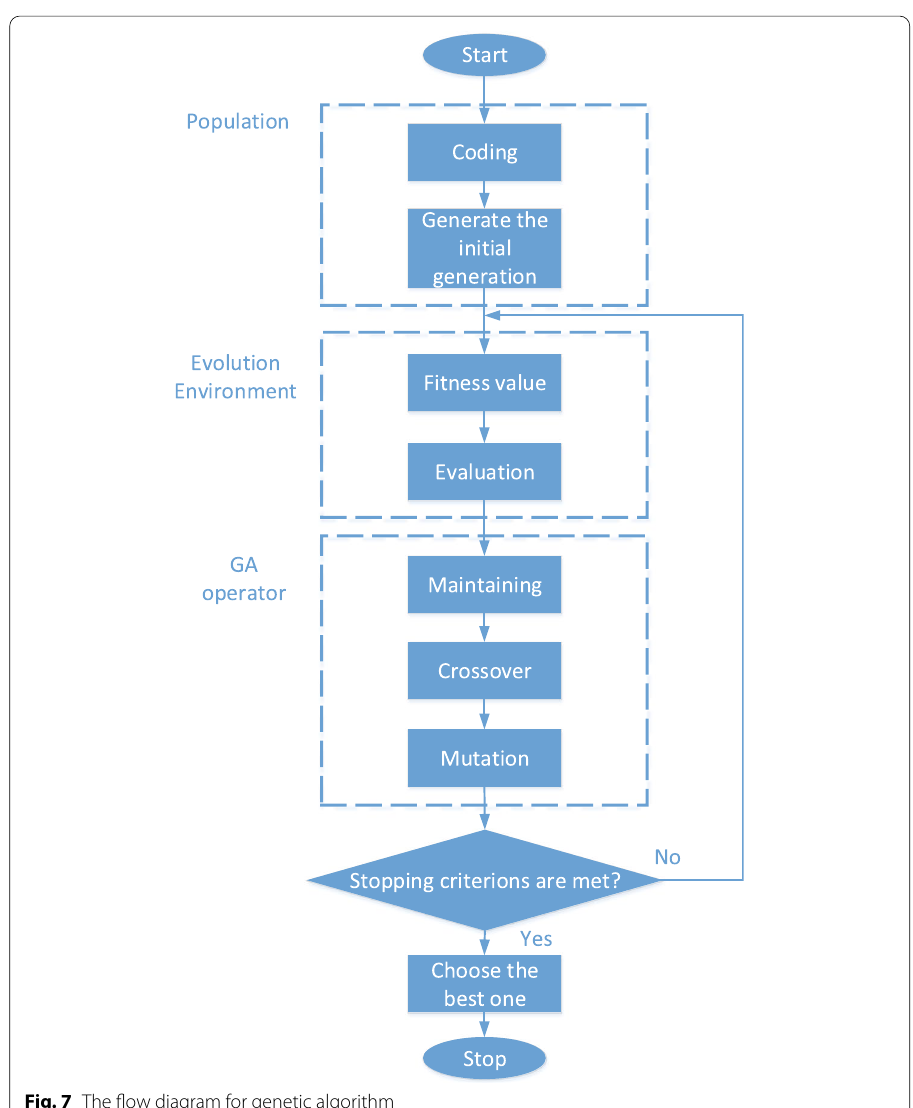
Fig. 7 The flow diagram for genetic